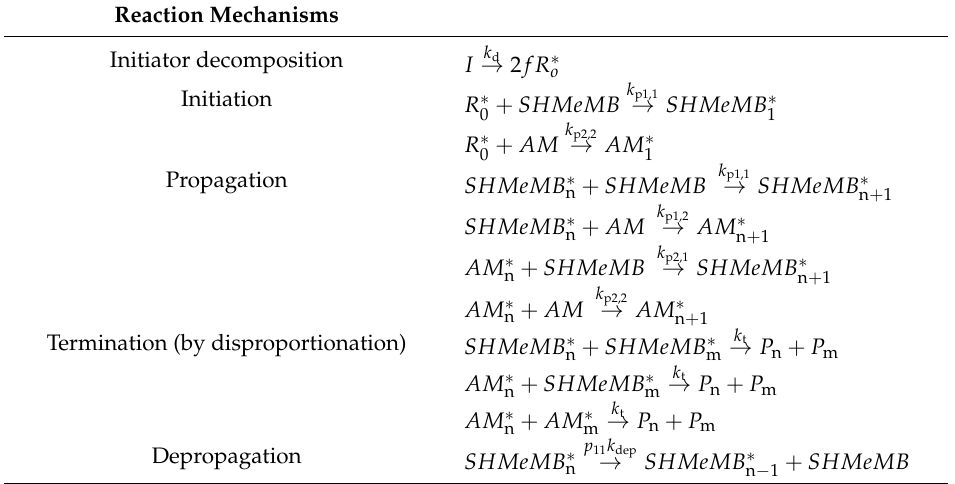
Table 1. Reaction mechanisms for the copolymerization of SHMeMB and acrylamide (AM). Reaction